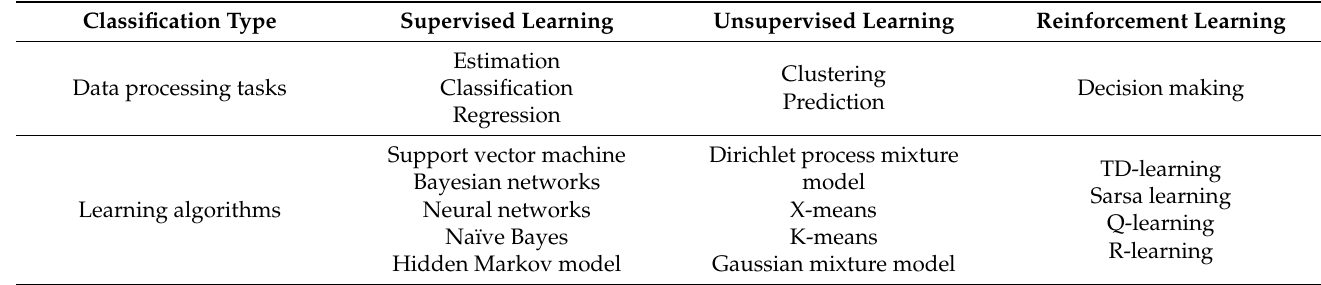
Table 3. Main ML